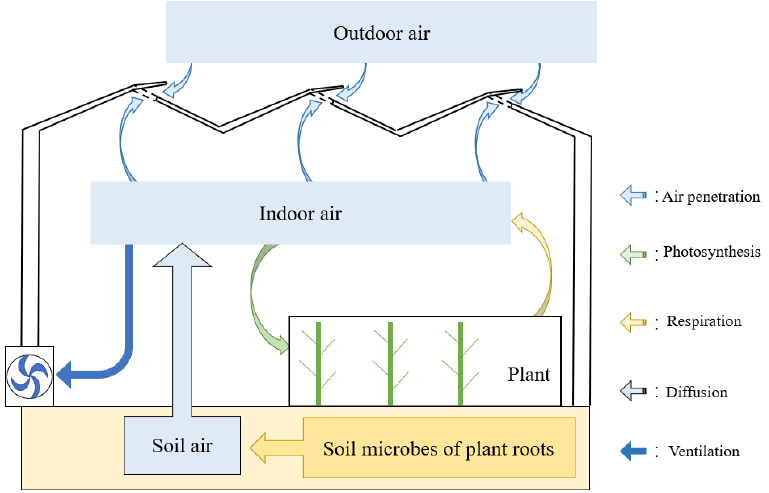
Figure 3. Dynamic entry and exit paths of CO 2 in the greenhouse.